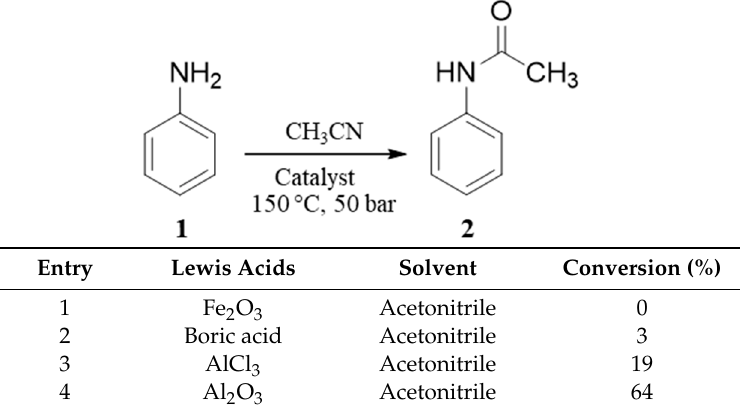
Table 1. Lewis acids screen in continuous-flow (CF) acetylation.